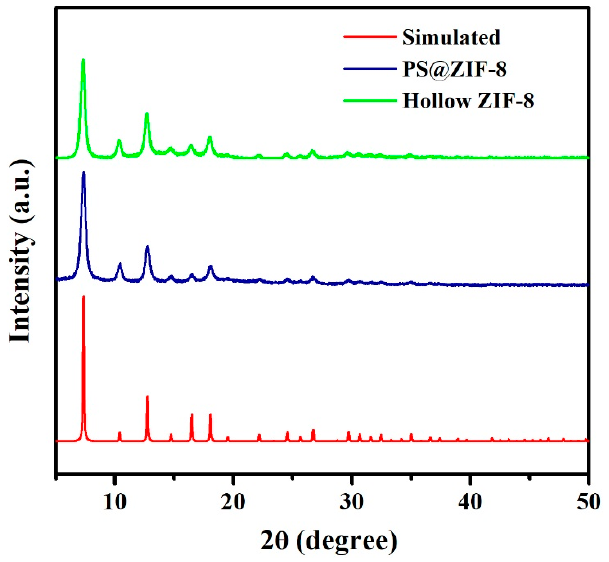
Figure 2. XRD patterns of ZIF-8, PS@ZIF-8, and hollow ZIF-8 particles with the simulated XRD pattern from the crystallographic data of ZIF-8.